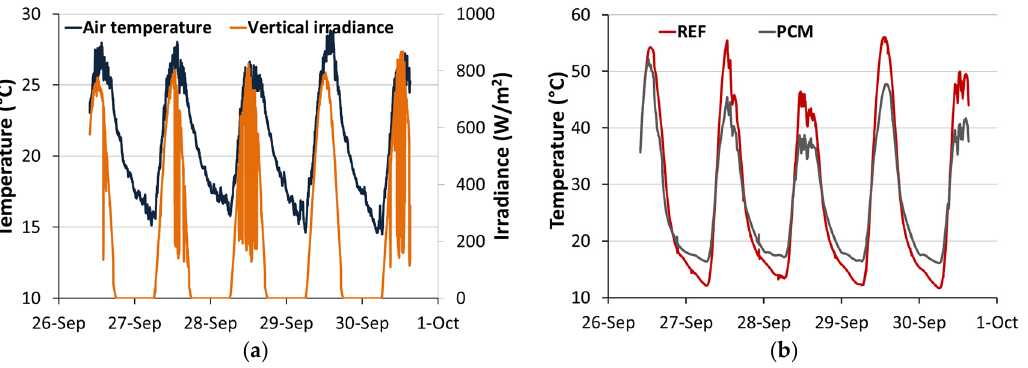
Figure 5. Experimental data from the warm season monitoring campaign: ( a ) trends of outdoor air temperature and global irradiance on a vertical plane; ( b ) trends of air temperature inside the REF box and the PCM box during the test.